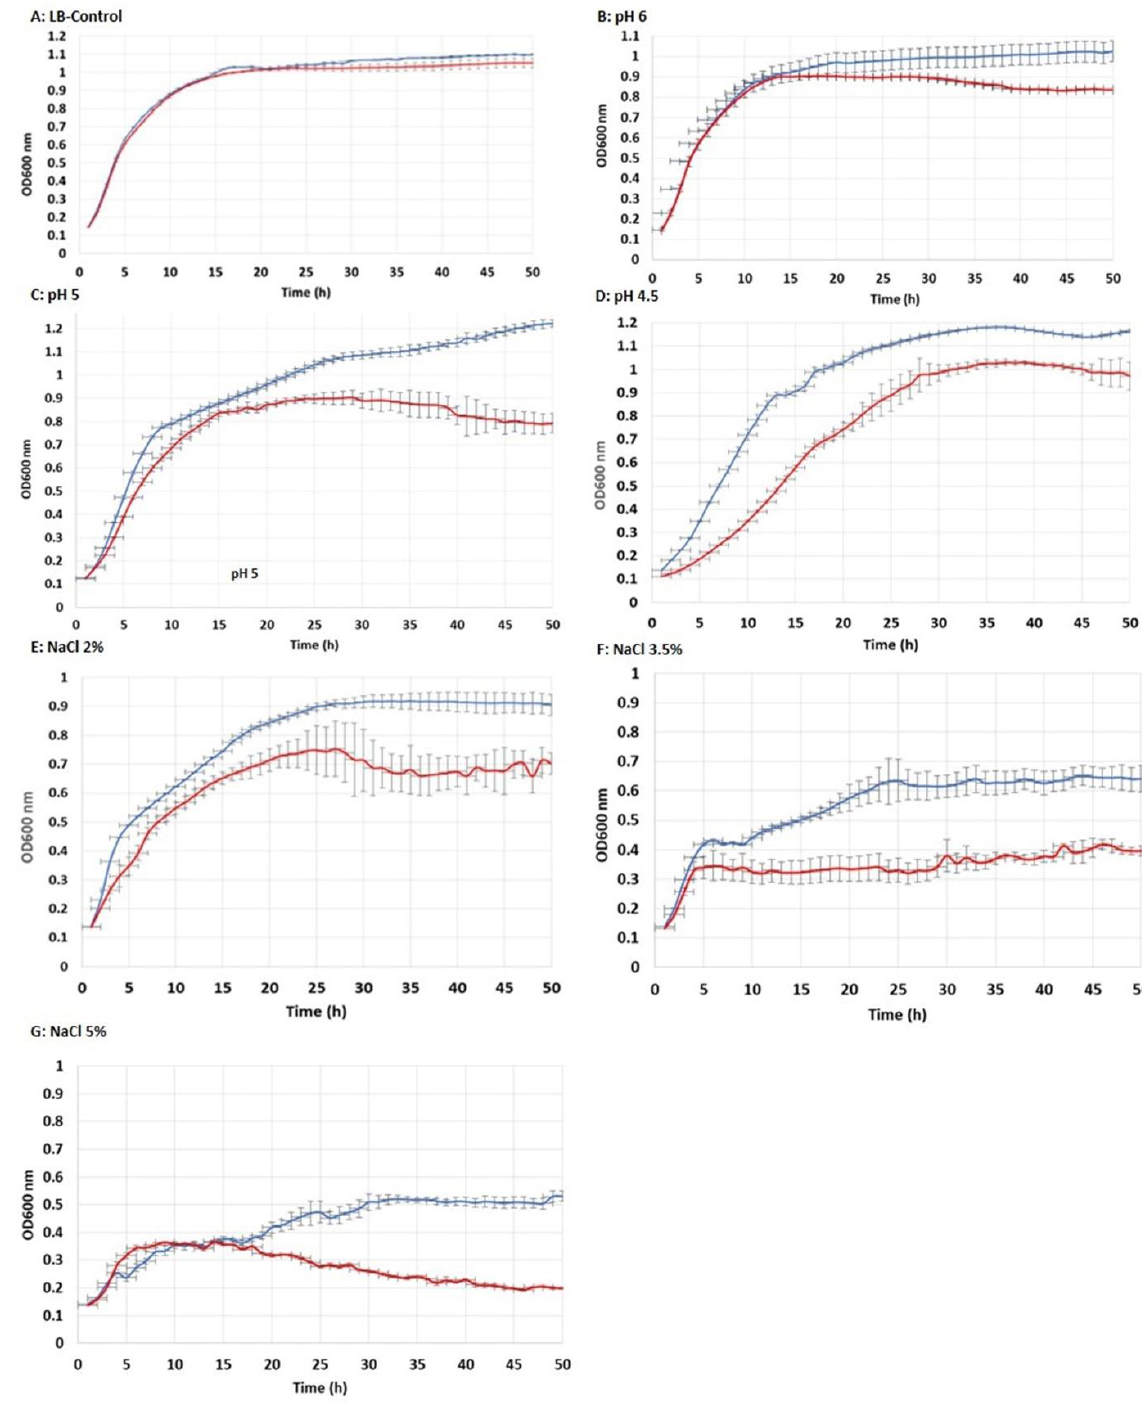
Figure 5. Growth curves of Escherichia coli in LB-MOPS broth supplemented with 100 µ g mL − 1 ampicillin (Ap). The optical density at 600 nm (OD 600 ) was measured every hour for each strain for 50 cycles (49 h). NC: E. coli negative control (red line). CaPCS2: E. coli cells carrying plasmids with the CaPCS2 gene (blue line). ( A ): Control assay (LB-MOPS-Ap) at neutral pH and NaCl 0.5%. ( B ): LB-MOPS-Ap broth at pH 6. ( C ): LB-MOPS-Ap broth at pH 5. ( D ): LB-MOPS-Ap broth at pH 4.5. ( E ): LB-MOPS-Ap broth supplemented with NaCl 2%. ( F ): LB-MOPS-Ap broth supplemented with NaCl 3.5%. ( G ): LB-MOPS-Ap broth supplemented with NaCl 5%. The graphs show the mean of the seven different clones tested for each strain (NC and CaPCS2).